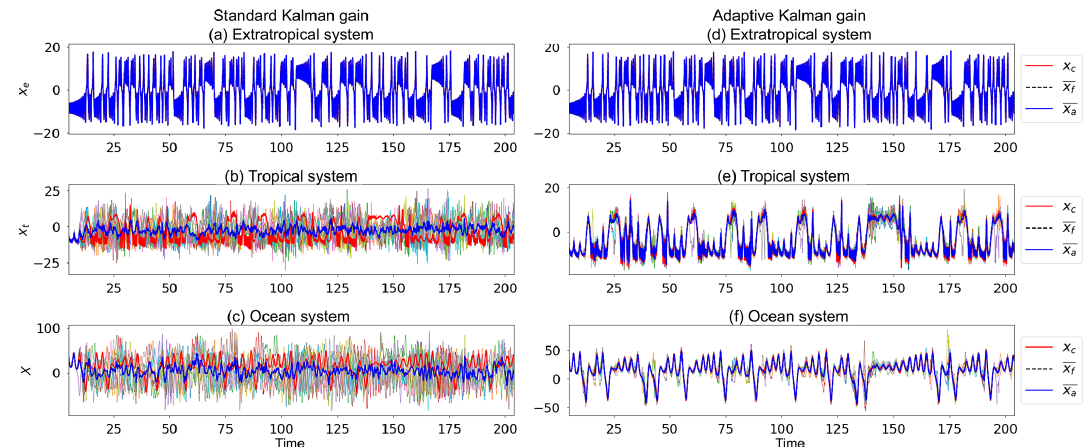
Figure 12. Trajectories of DA experiments using variable CLVs, left-transform matrix (Eq. 17b), and perfect observations from the extrat- ropical subsystem of a control run ( x e ,y e ,z e ), with (a–c) the standard Kalman gain (Eq. 9a) and (d–f) the adaptive Kalman gain (Eq. 28). Trajectories shown are control run (red), ensemble mean (blue), and individual ensemble members (multicoloured). For conciseness we only show the results for the x coordinate of each subsystem. The other two coordinates behave similarly. Parameters: assimilation window 0.02, inflation factor 1%, 10 ensemble members, observation error covariance R = I 4 . Table 6. Summary metrics of DA experiments using a left-transform matrix (Eq. 17b) and the full extratropical subsystem as observations ( x e , y e , z e ). We use perfect observations (no random error added to the control run) with the observation error covariances set to the standard values as in Yoshida and Kalnay (2018). Parameters: assimilation window 0.02, inflation factor 1%, 10 ensemble members. Method